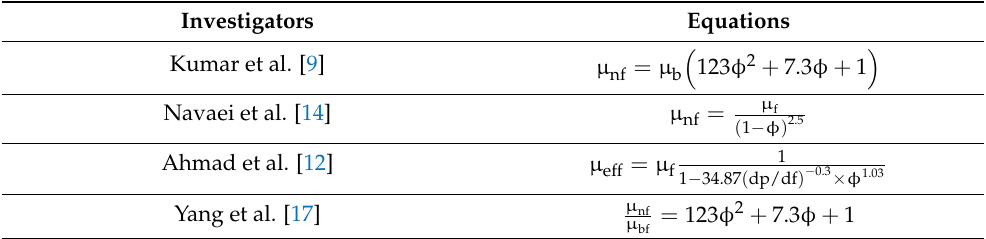
Table 4. Equations used for calculating the viscosity of